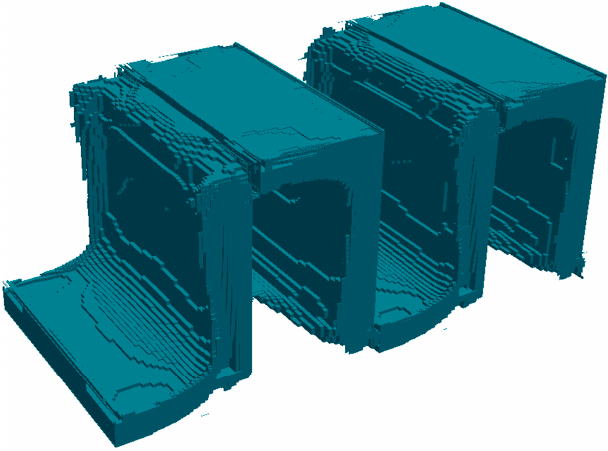
Figure 10. Three-dimensional configuration of jet regions of each chamber in the mixing tank for RANS. Jet flow region was identified using vorticity gradient.